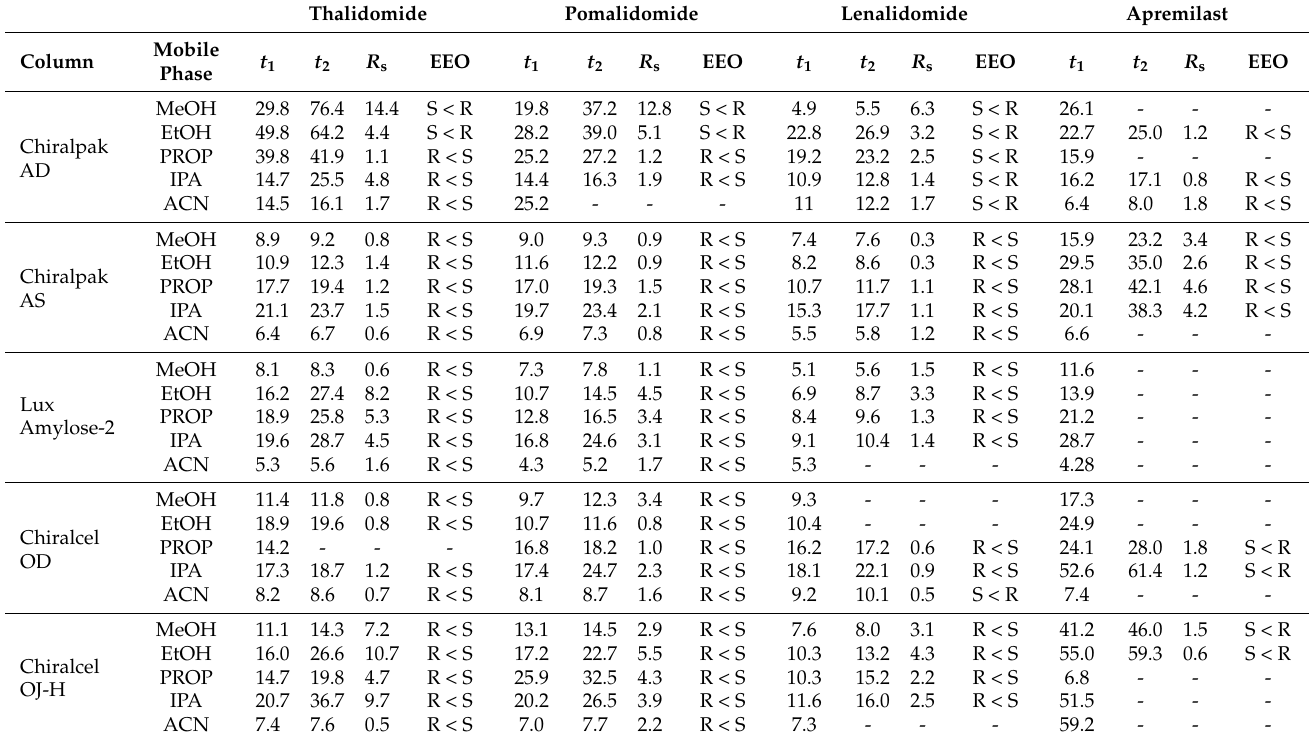
Table 1. Chromatographic data, enantiomeric elution order (EEO), retention times of the enantiomers and resolution of the mobile phase and CSP screening for the chiral separation of thalidomide analogues in polar organic mode. Flow rate: 0.5 mL/min. Temperature: 20 ◦